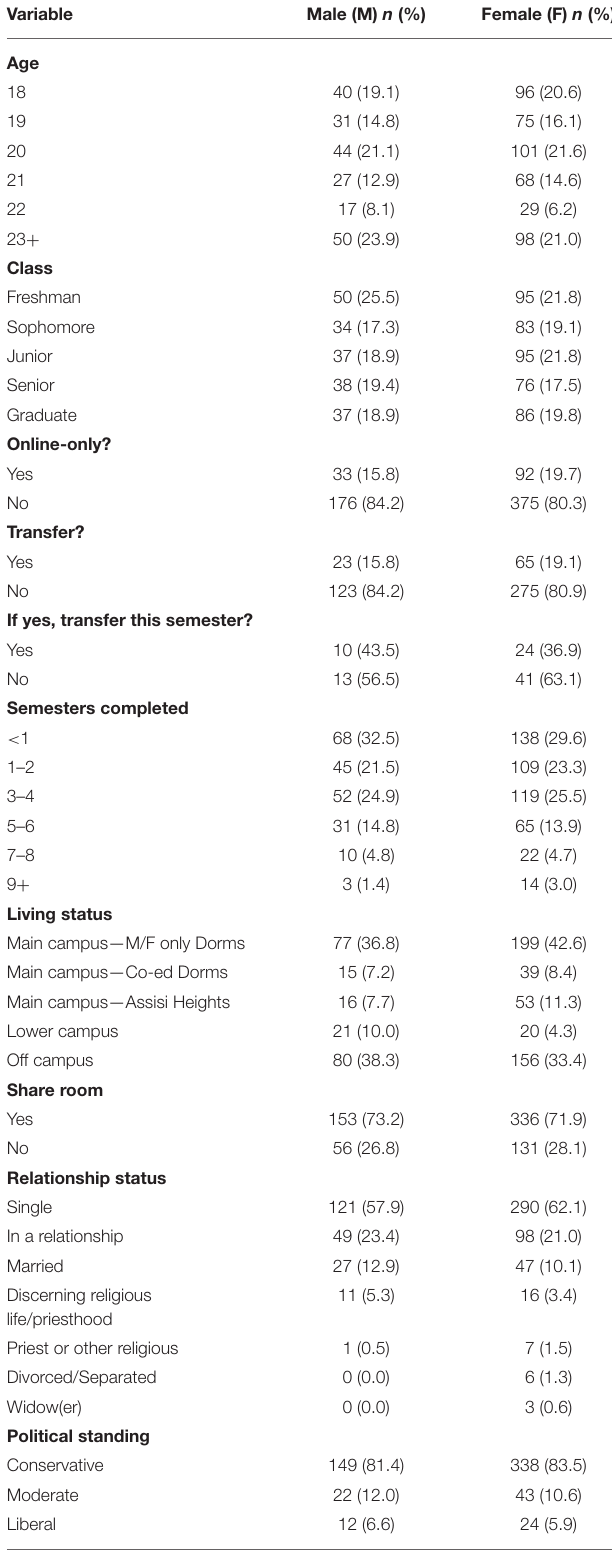
TABLE 1 | Summary of current demographic